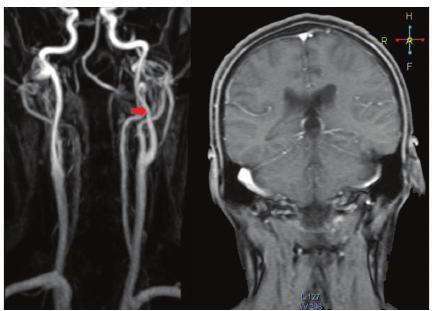
Figure 1: MRA and MRI with coronal slices demonstrating moder- ate narrowing of the left internal carotid artery just below the skull base (red arrow).